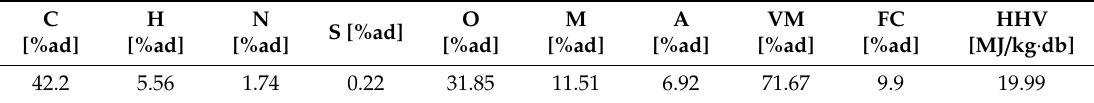
Table 1. Ultimate & proximate analyses of biomass fuel used in Aspen